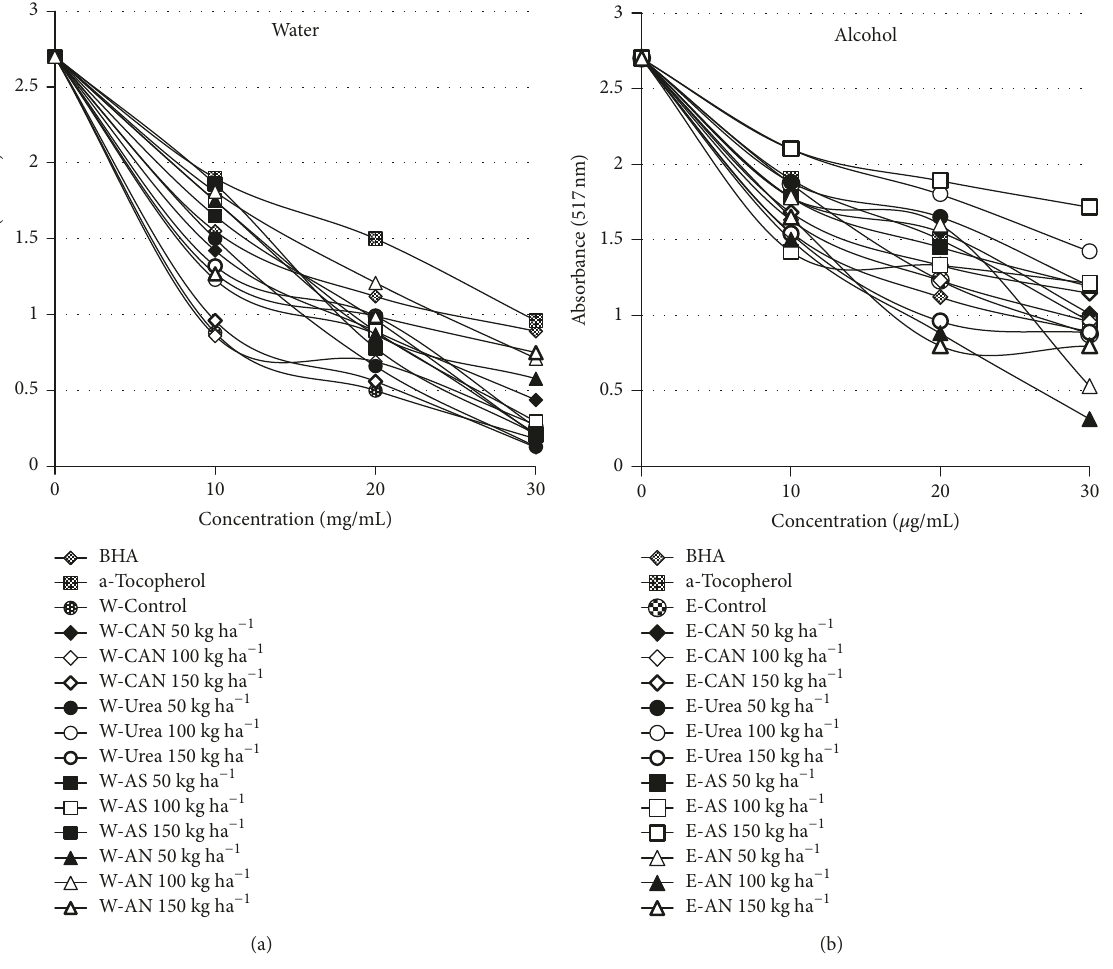
Figure 3: The DPPH ∙ scavenging effect of water extracts, alcohol extracts, BHA, and 𝛼 -tocopherol at different concentrations (10–30 𝜇 g/ mL −1